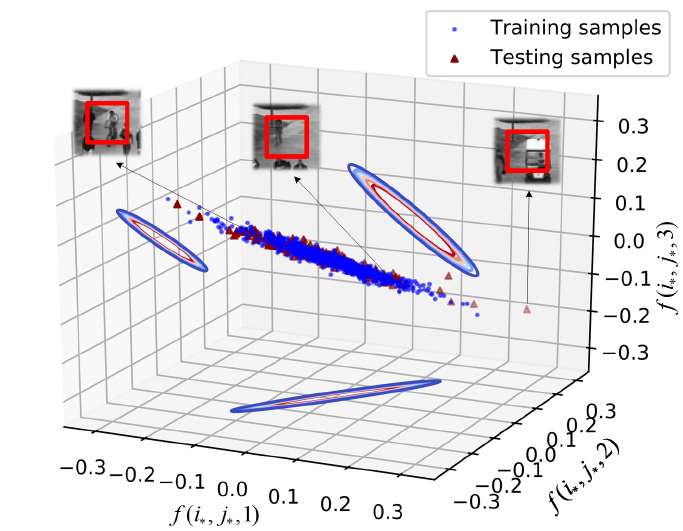
Figure 3. The distribution of the receptive field from the same position in the three-dimensional feature